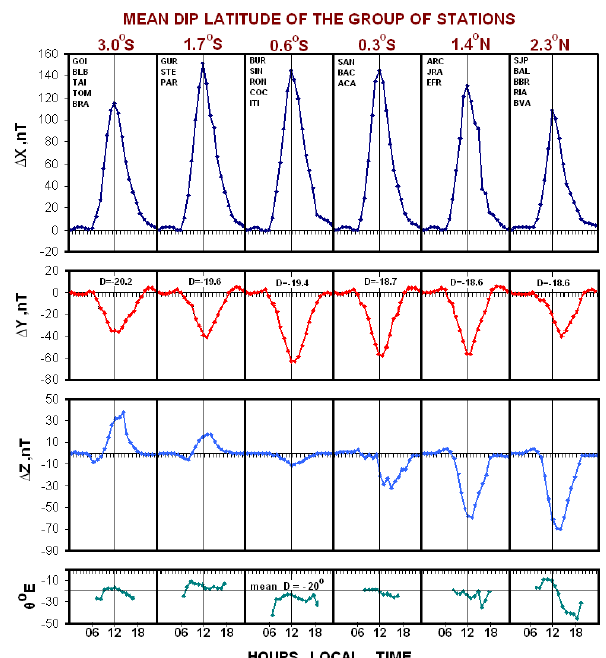
Fig. 5a. Mean daily variations of ranges of X, Y and Z fields and of the electrojet current direction , θ (direction of H east of geographic north = arc tan( 1Y / 1X ) averaged for groups of stations at 3 ◦ S, 2 ◦ –1 ◦ S, 1 ◦ –0 ◦ S, 0 ◦ –1 ◦ N, 1 ◦ –2 ◦ N and 2 ◦ –3 ◦ N dip latitudes for all the sixteen quiet